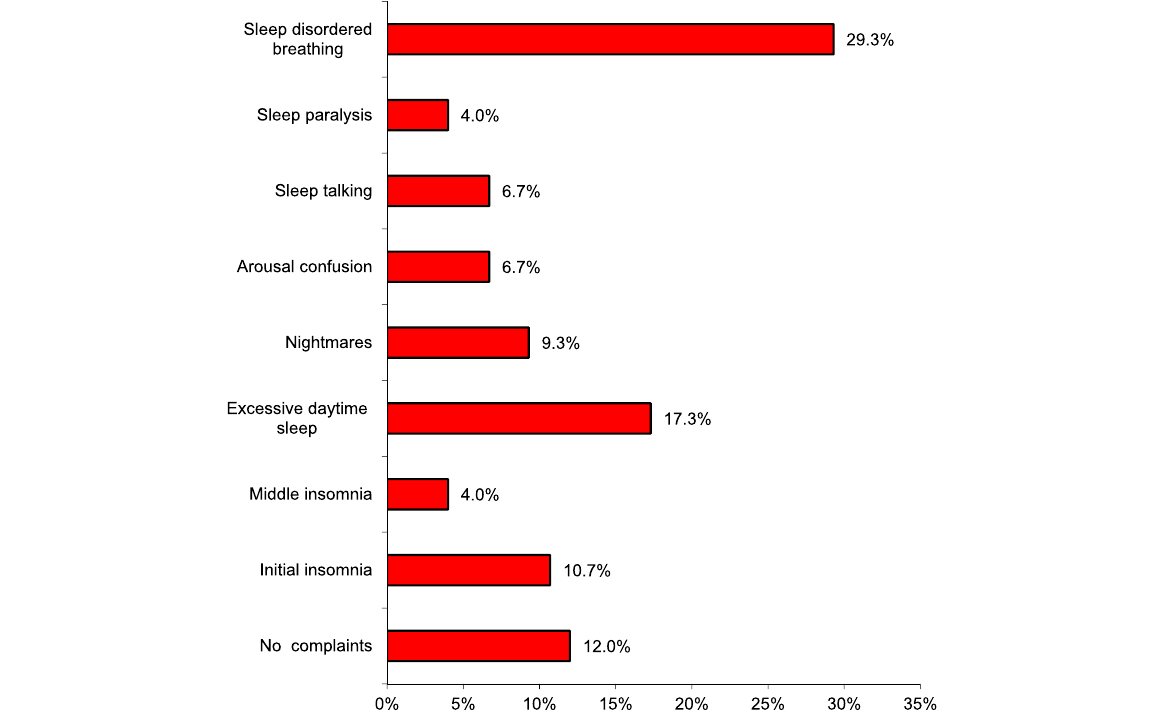
Table 2 Data of the applied questionnaires